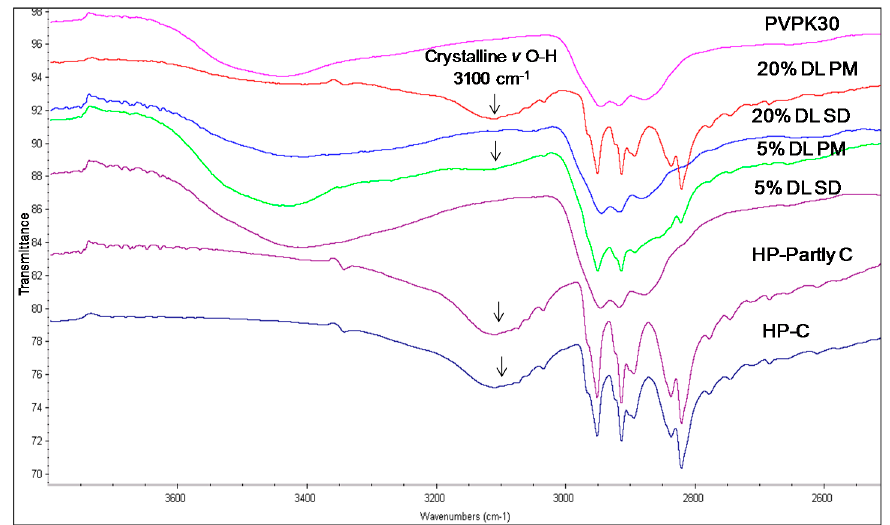
Figure 3. FTIR spectra of haloperidol PVPK30 solid dispersion (SD) and physical mixture (PM) showing O-H stretching region at 3100 cm − 1 in crystalline (C), partly crystalline (partly C) and physical mixture (PM), which disappears in solid dispersion (SD) at both 5% and 20% drug loading (DL).